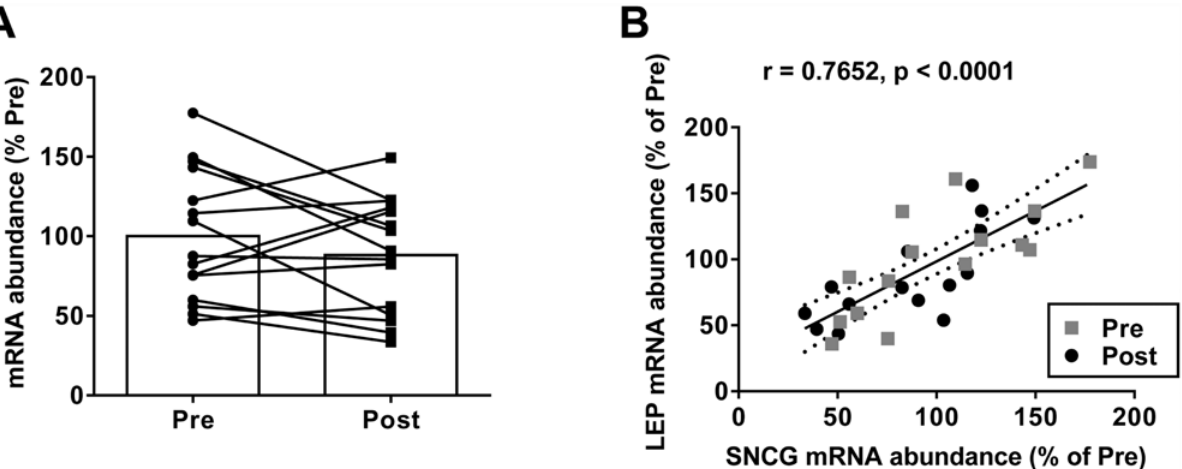
Fig 4. COHORT 2: Effect of 11 weeks PIO treatment on synuclein- γ (SNCG) mRNA expression in subcutaneous white adipose tissue (SC-WAT) in subjects with type 2 diabetes (n = 15). (A) . Pre- and post-treatment SC-WAT expression levels of SNCG and LEP in the same subjects were highly- correlated, using Pearson ’ s correlation statistic (B) . The average transcript level in pre-treatment biopsies was considered 100%. Raw data is provided in S1 Data.